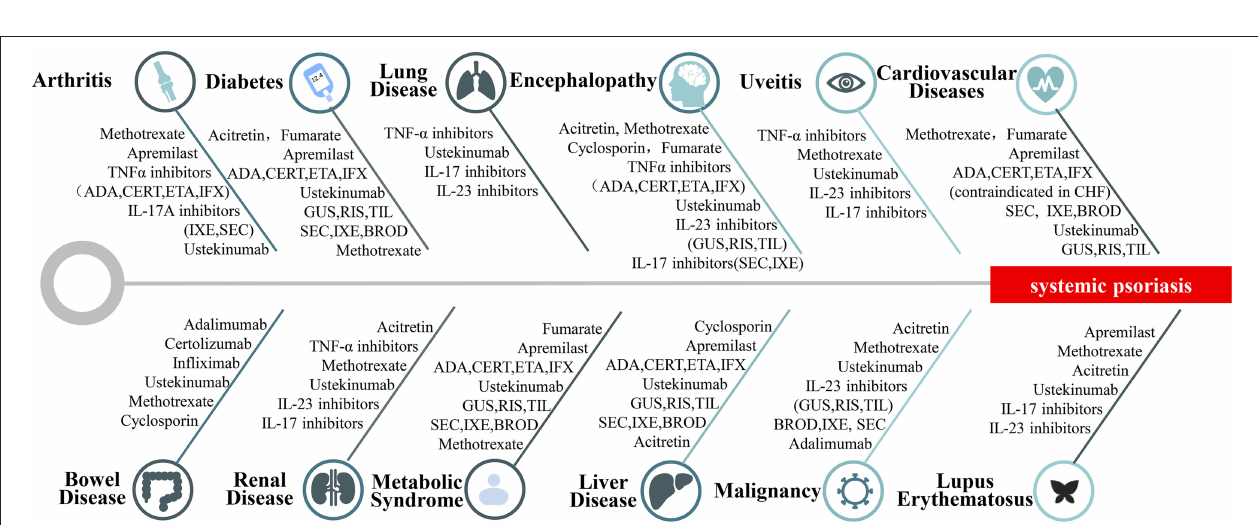
Frontiers in Medicine |